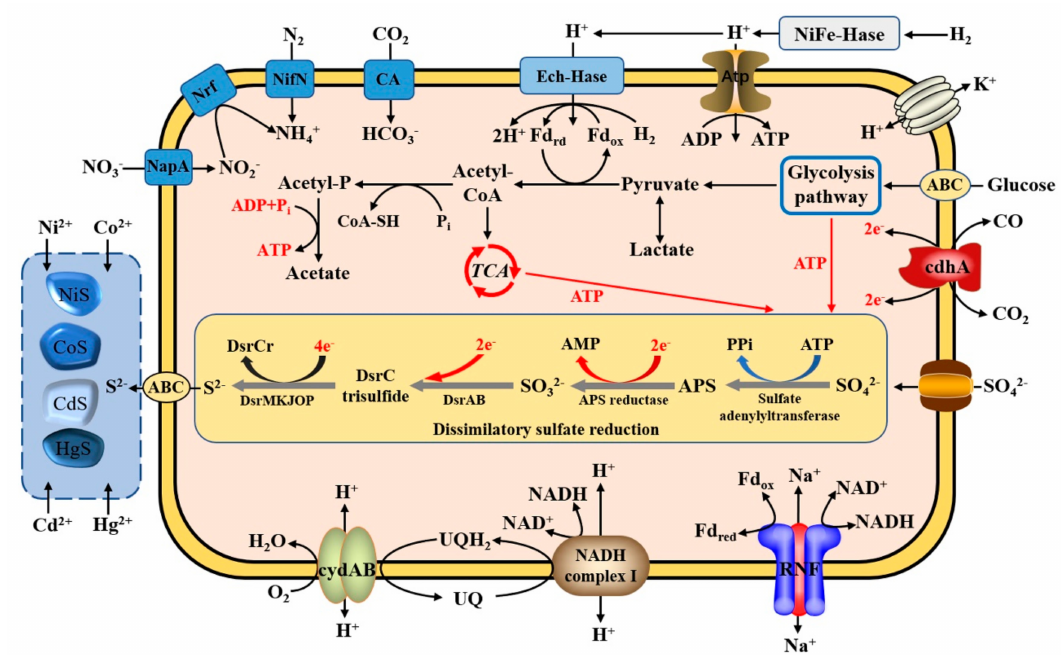
Figure 6. Proposed lifestyle of P. cashew SRB007. Abbreviations: TCA, tricarboxylic acid cycle; FeFe-Hase, FeFe-hydrogenase; Atp, ATP synthase; ATP, 5’-Adenylate triphosphate; ADP, adenosine diphosphate; AMP, adenosine monophosphate; Ech- Hase, energy-conserving membrane-bound hydrogenase; CA, carbonic anhydrase; NifN, nitrogenase; Nrf, cytochrome c nitrite reductase; NapA, nitrate reductase catalytic subunit; cydAB, cytochrome bd-I ubiquinol oxidase subunit; cdhA, CO dehydrogenase/acetyl-CoA synthase complex subunit epsilon; UQ, ubiquinone; UQH 2 , Cytochrome C reductase; RNF, the sodium translocating NADH: Ferredoxin oxidoreductase; DsrAB, dissimilatory sulfite reductases; PPi, pyrophosphoric